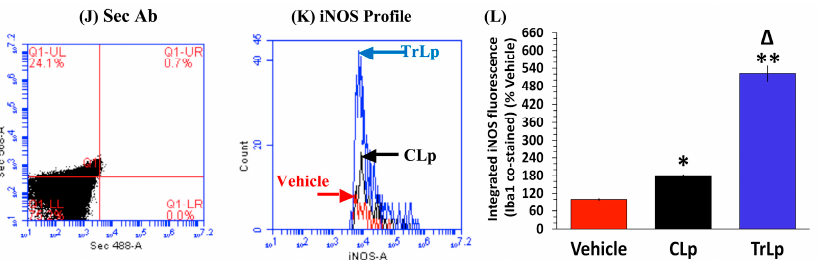
Figure 5. A 5-day treatment of GBM mice shows that TrLp is significantly more potent than CLp in causing repolarization of iNOS low , Arg1 high M2-like TAM to iNOS high , Arg1 low M1-like TAM. GL261 cells (10 5 ) were implanted in the right brain of 3-month old male C57BL/6 mice on day 1 by stereotaxic injection and randomly divided into three groups: Vehicle, CLp (5 mM) and TrLp (1.28 mM+). The GBM mice from the three groups were treated (i.p. 200 μ L Vehicle, CLp, or TrLp) from day 12 to day 16 (five times, every 24 h) and sacrificed on day 17. Dispersed GBM tumors from mice of the three groups were double-stained with antibodies against Iba1 and ARG1 or iNOS (double-stained events indicated by red ellipses in the UR quadrant) and analyzed via flow cytometry. ( A , E , F ) The Iba1+ TAM in the Vehicle-treated, were ARG1 high (M2); ( A – C , E , F ) Compared to the Vehicle-treated, the CLp-treated, Iba1+ TAM (UR, red ellipse) showed 63% less ARG1 IF (* p = 8 × 10 − 4 ) and the TrLp-treated TAM (UR, red ellipse) showed 84% less ARG1 IF (** p = 1.3 × 10 − 4 ) ( E , F ); ( F ) This suppression was 21% greater in the TrLp mice than in the CLp cohort ( Δ p = 4.4 × 10 − 3 ); ( D ) 2° antibody-treated samples showed background staining; ( G , K , L ) The Iba1+ TAM in the Vehicle-treated GBM mice were iNOS low (M2 type); ( G – I , K , L ) Compared to the Vehicle-treated, the CLp-treated, Iba1+ TAM (UR, red ellipse) showed 80% greater the iNOS IF (* p = 1.4 × 10 − 4 ) and the TrLp-treated TAM showed 422% higher iNOS IF (** p = 1.5 × 10 − 4 ) ( K , L ); ( L ) This increase iNOS was 342% greater in the TrLp-treated than in the CLp cohort ( Δ p = 0.001); The graphs represent data (mean ± S.E.M.) obtained from Vehicle ( n = 3 mice), CLp ( n = 3 mice) and TrLp ( n = 3 mice); ( J ) 2° antibody-treated samples showed background staining.